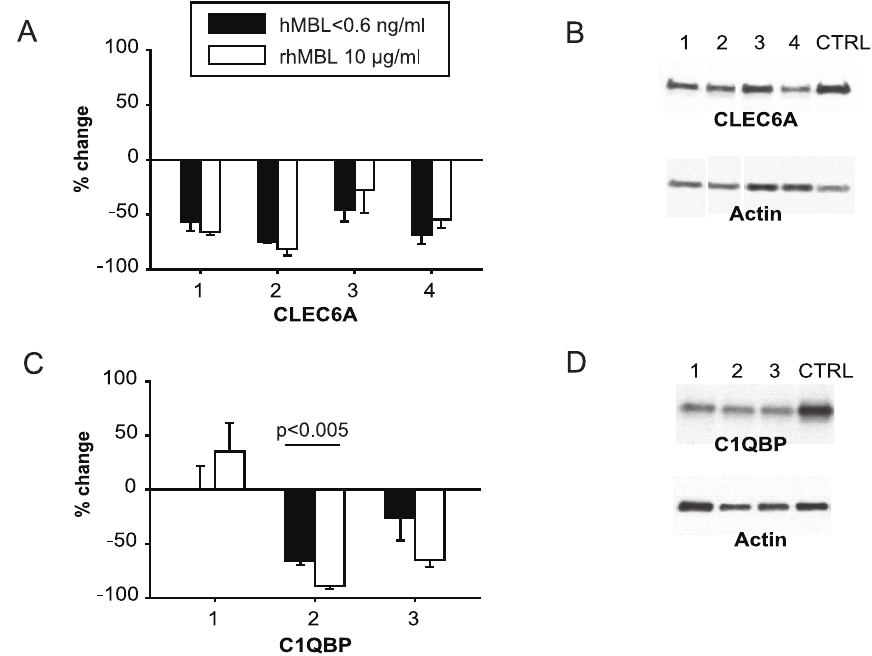
Figure 6. RNA interference screen of candidate cellular receptors for EBOV and MBL. (A–D) We targeted 24 candidate lectin, scavenger and other putative receptors using pLKO.1 lentiviral vectors that expressed 4 or 5 unique short hairpin RNA (shRNA) constructs per gene. We transduced HEK293F cells in quadruplicate using 4.6 6 10 8 viral particles (shRNA-expressing vectors or empty control vectors) with hexadimethrine bromide (6 m g/ml) at 37 u C for 18 hours. We selected transduced cells with 5 m g/ml puromycin over 48 hours and determined cell viability with alamarBlue reagent (resazurin reduction assay). We then infected cells in quadruplicate with HIV-EBOV GP virion-like particles (1000 pg p24/100 m l) with or without rhMBL. After 48 hours we measured rates of single-round infection (luciferase assay) and adjusted results for cell viability. Percentage change in infection was normalized to the empty pLK0.1 control vector (CTRL). Shown are positive hits (A, C) which were defined as $ 66% reduction in infection by at least two shRNA constructs for any particular gene. Reductions in protein expression produced by shRNAs (western blots; B, D) relative to that produced by the empty pLK0.1 control vector are shown. Relative densitometry was performed with ImageJ (NIH) by adjusting for variations in the actin loading controls (adjusted relative densities for CLEC6A: lane 1, 0.60; lane 2, 0.56; lane 3, 0.51; lane 4, 0.35; control, 1.0. C1QBP: lane 1, 0.32; lane 2, 0.52; lane 3, 0.47; control 1.0).